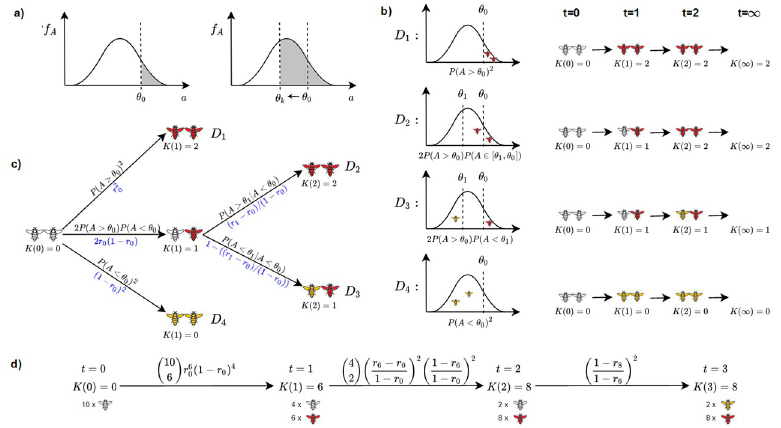
Fig 1. Modelling stinging response for n = 2. A) Probability density function of aggressiveness. B) Four different situations for a group of two bees. Simulation of different stinging behaviour across time for four different initial aggressiveness situations. C) A Markov chain model of four different stinging scenarios for a group of two bees. D) An example trace of a Markov chain model generated for n =